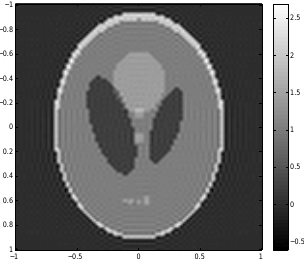
Figure 21. Gegenbauer reconstruction of the Shepp-Logan brain phantom on [128 × 128] uniformly spaced grid points. dynamic selection of the reconstruction pa- rameters and resulting in an 89% reduction in size over the original